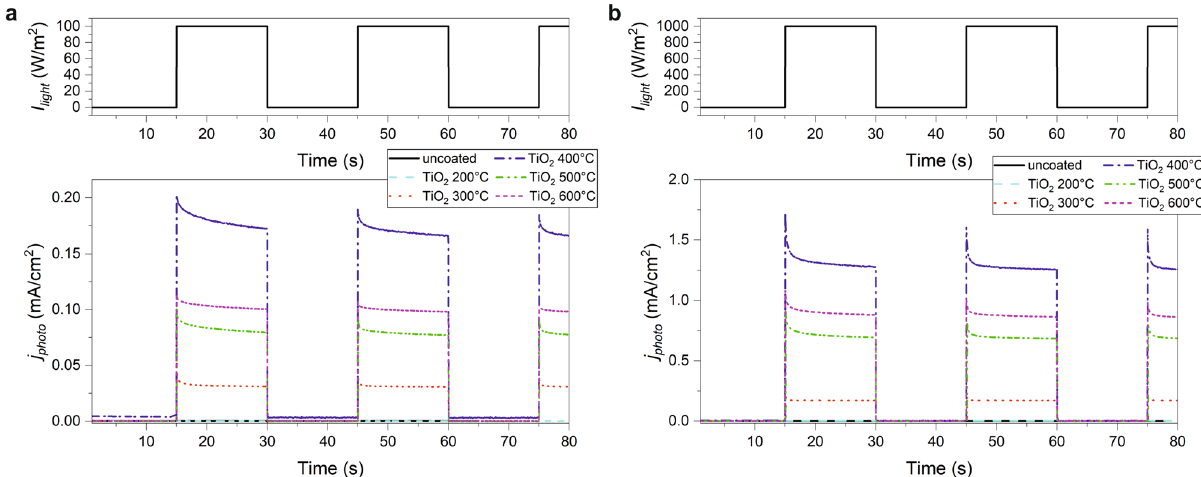
Figure 6. Chopped light chronoamperometric measurements at an applied potential of 0.1 V versus Ag/AgCl of neat and TiO 2 -coated FTO glass slides calcined at temperatures indicated in the legend under ( a ) 100 W / m 2 and ( b ) 1000W / m 2 irradiation at 369